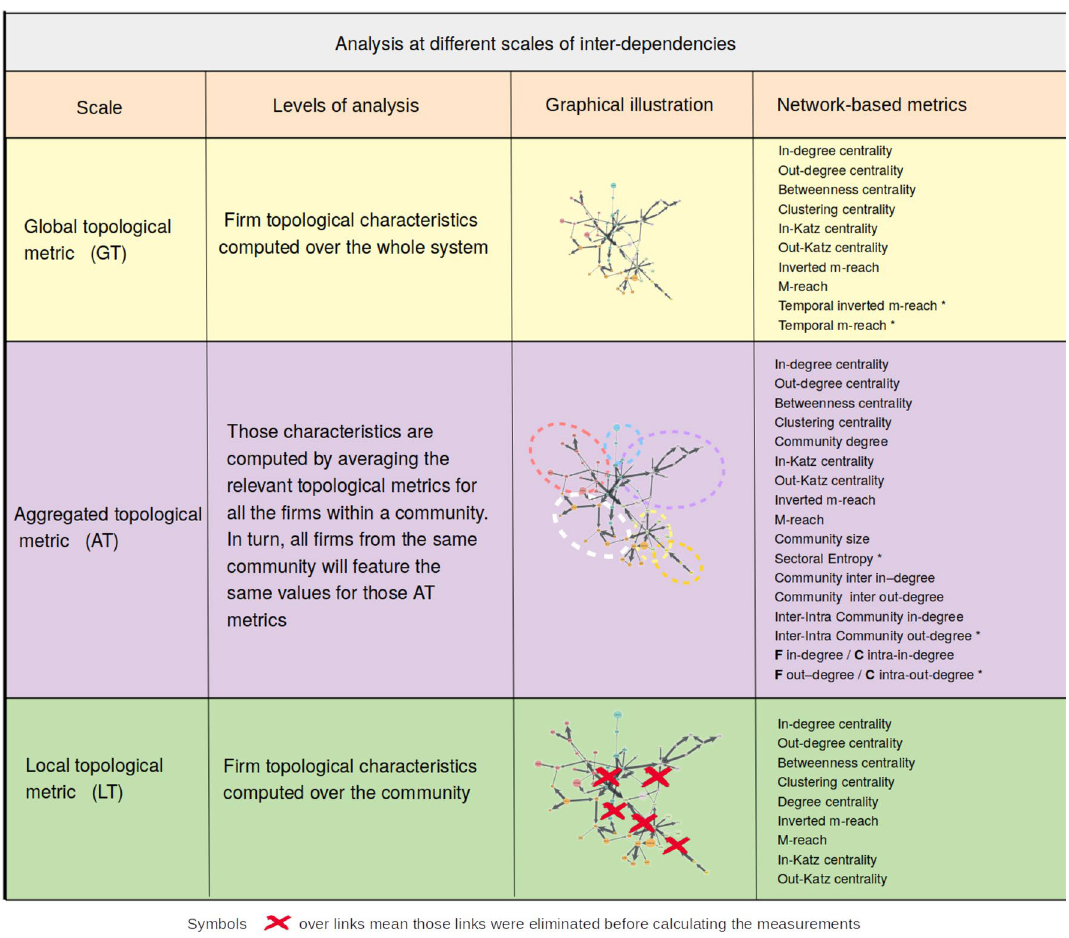
Figure 2. Three levels of analysis: System wide firms-based metrics, Community firm-based metrics and Community-based metrics. The figure displays the labels of the topological metrics along with their corresponding level. We consider three levels. System wide firms-based metrics are computed for each firm based on information stemming from the whole network. Community firm-based metrics are computed for each firm based on information stemming exclusively from the community (i.e. sub-networks). Community- based metrics are computed at the community level. Each category is associated to a stylized network to illustrate which area is used to compute the metrics. Metrics surmounted by an ∗ correspond to the variables labelled “new” in the regression sections from each relevant